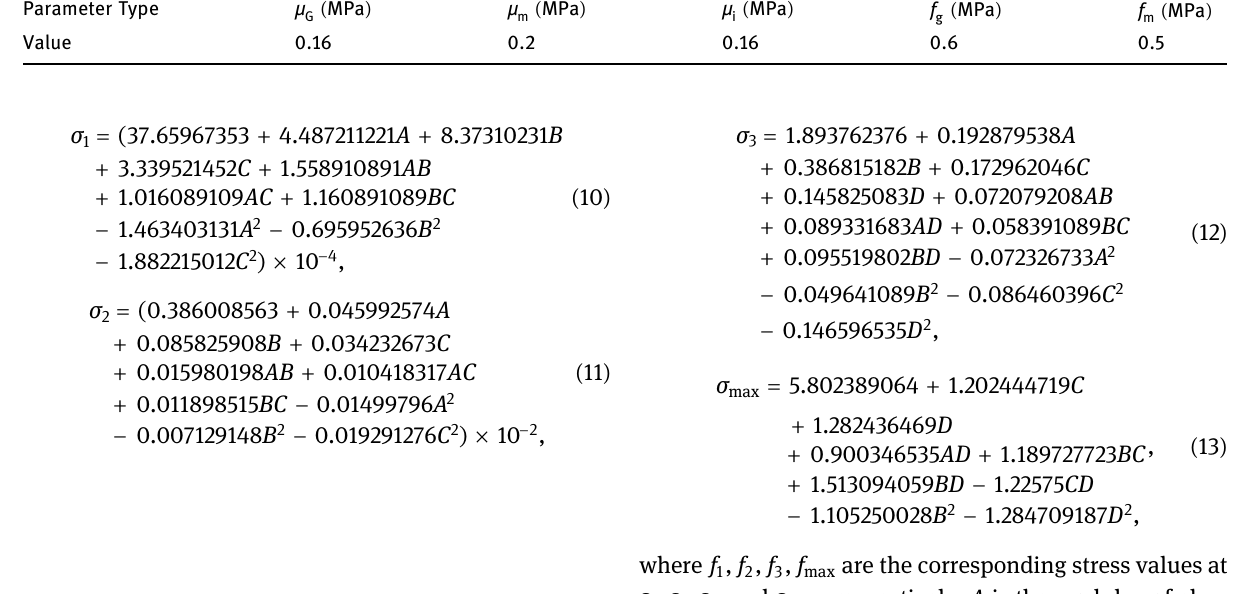
Table 4: Response surface design test parameter